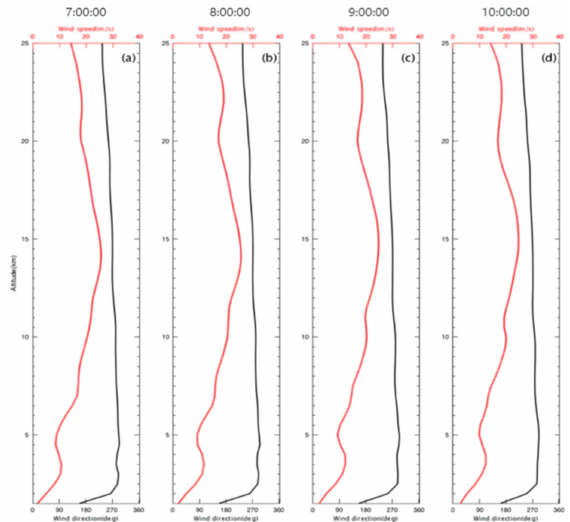
Figure 4. Wind profiles obtained from weather report before the experiment, ( a – d ) are the wind profiles at the time of 7:00:00, 8:00:00, 9:00:00, and 10:00:00 respectively. The red curve represents the wind speed and the black curve represents the direction of the wind.